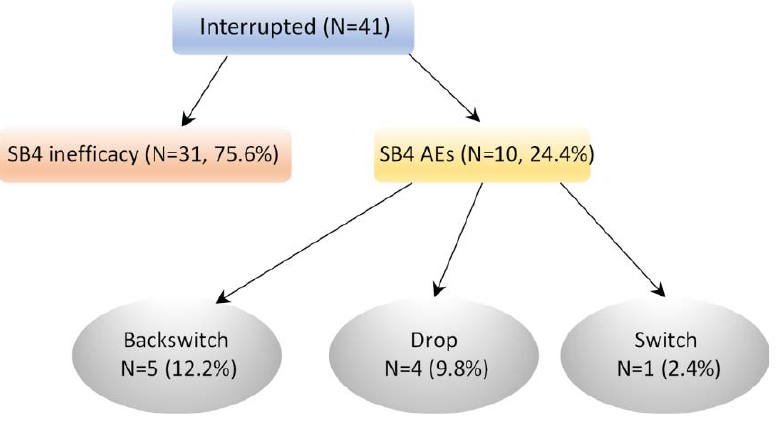
Figure 4. Flow diagram showing the number of patients discontinuing SB4 treatment after receiving ETA.